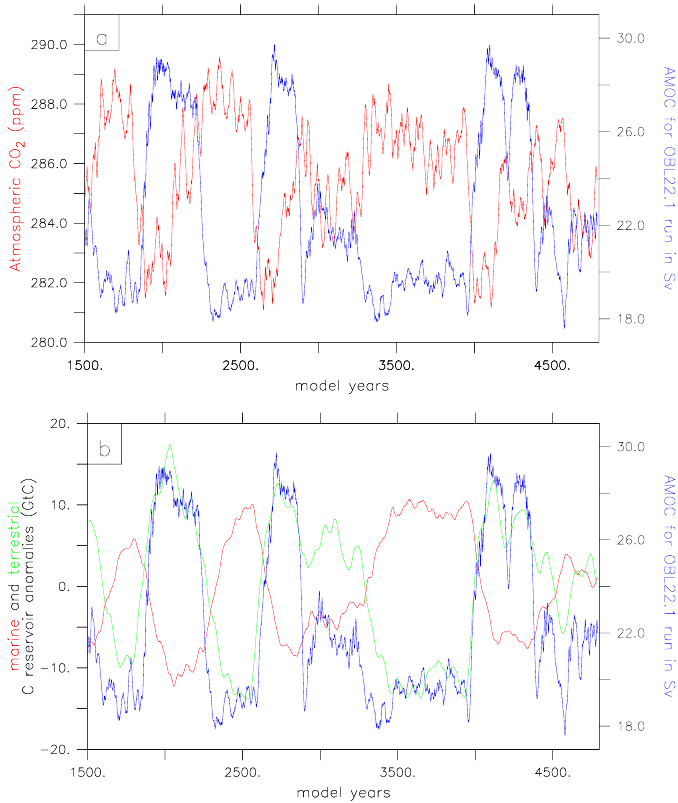
Fig. 10. (a) Atmospheric CO 2 content (red) in ppm and AMOC (blue) for OBL22.1 run. (b) Carbon reservoir anomalies for the ocean (red) and the vegetation (green) in GtC and AMOC (blue) for OBL22.1 run in Sv. A running mean of 25years was applied for all timeseries.